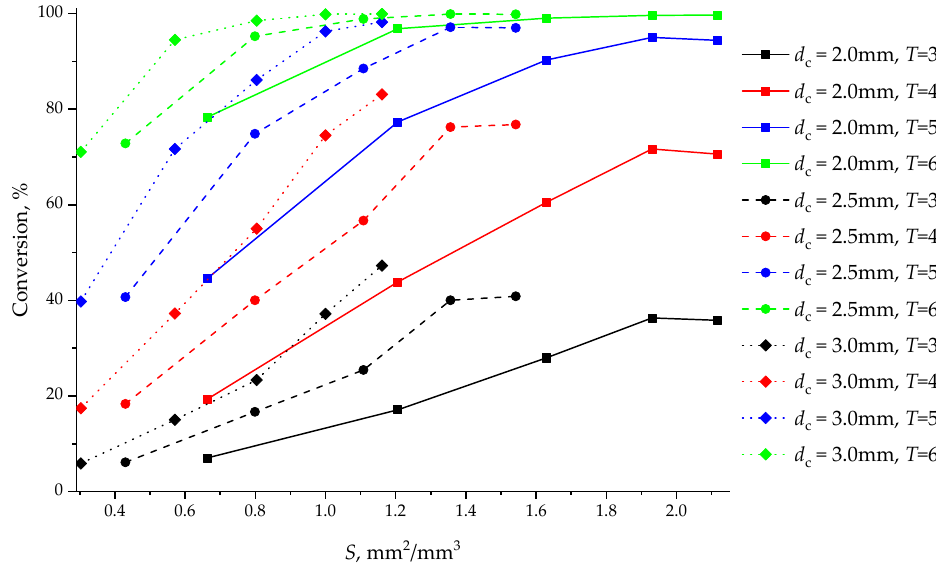
Figure 14. Conversion depending on the catalyst surface area.